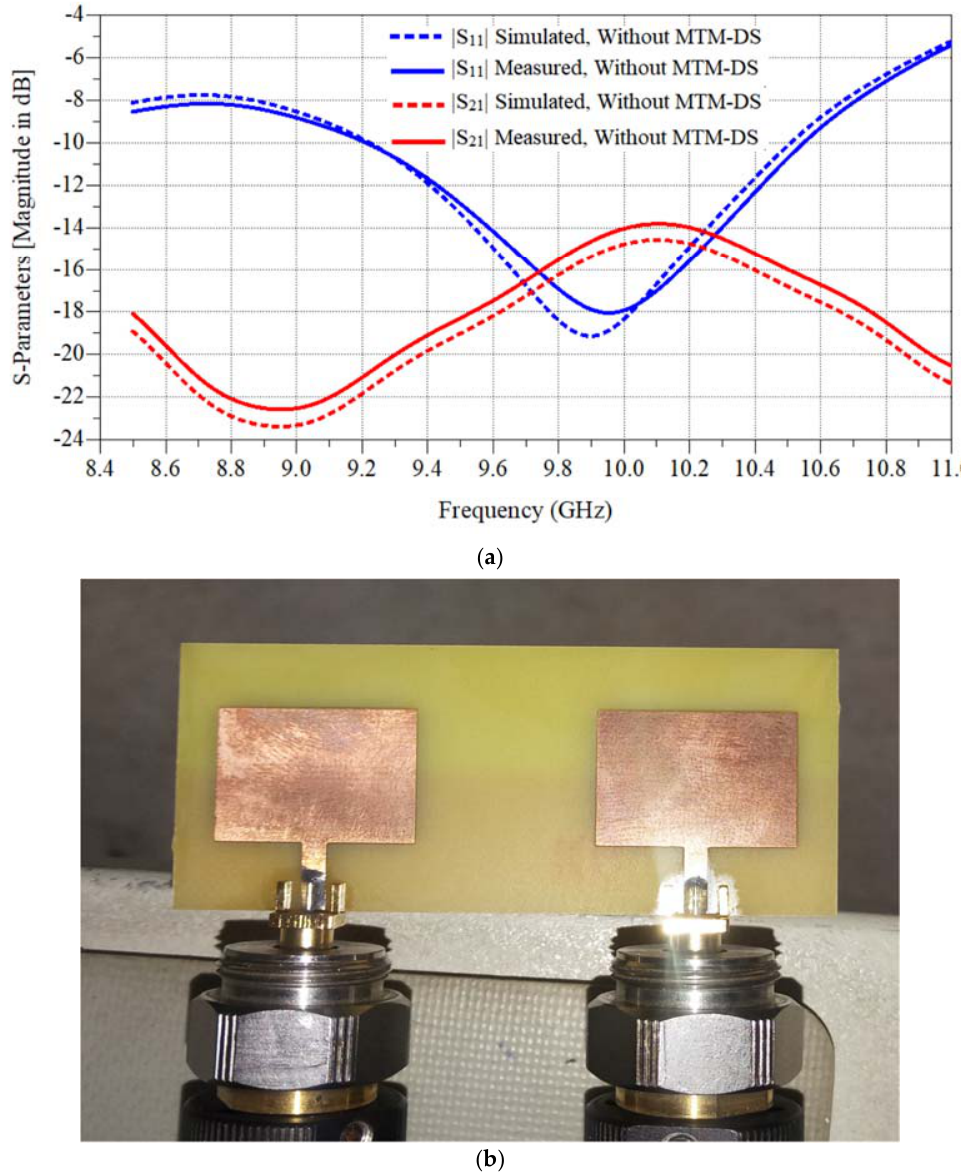
Figure 3. The fabricated 2 1 × antenna microstrip patch antenna array without decoupling slab. ( a ) Simulated and measured S-parameters results. ( b ) Array photo.